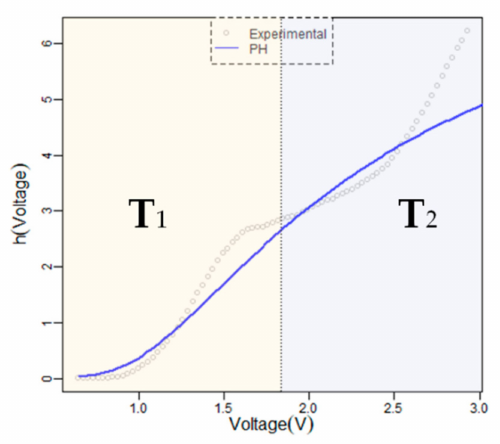
Figure 2. Statistical PH fits of the hazard rate function of reset